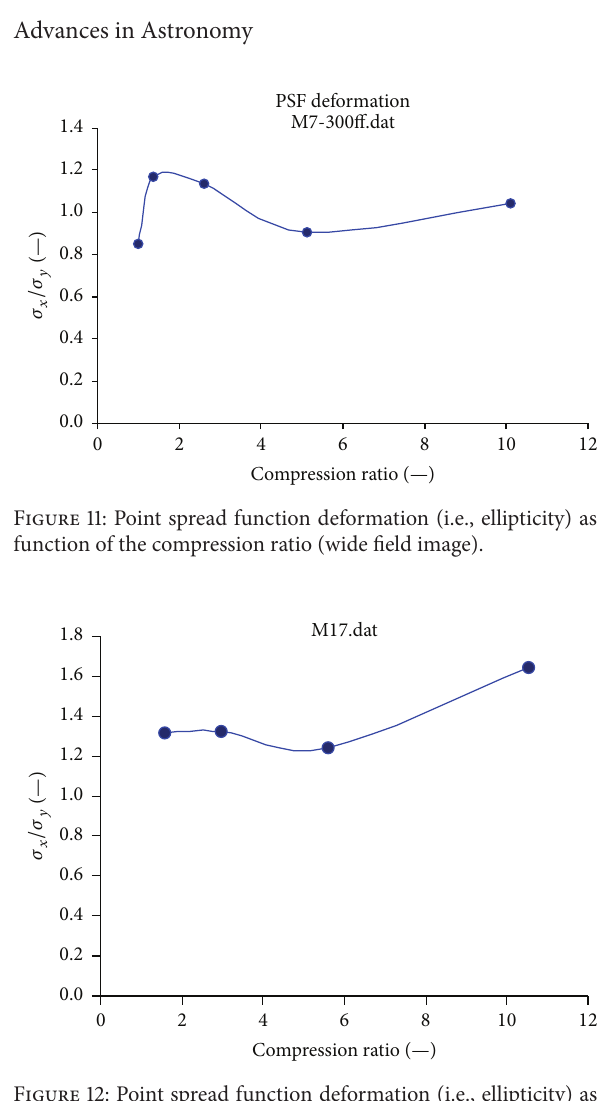
Figure 12: Point spread function deformation (i.e., ellipticity) as a function of the compression ratio (deep sky image).